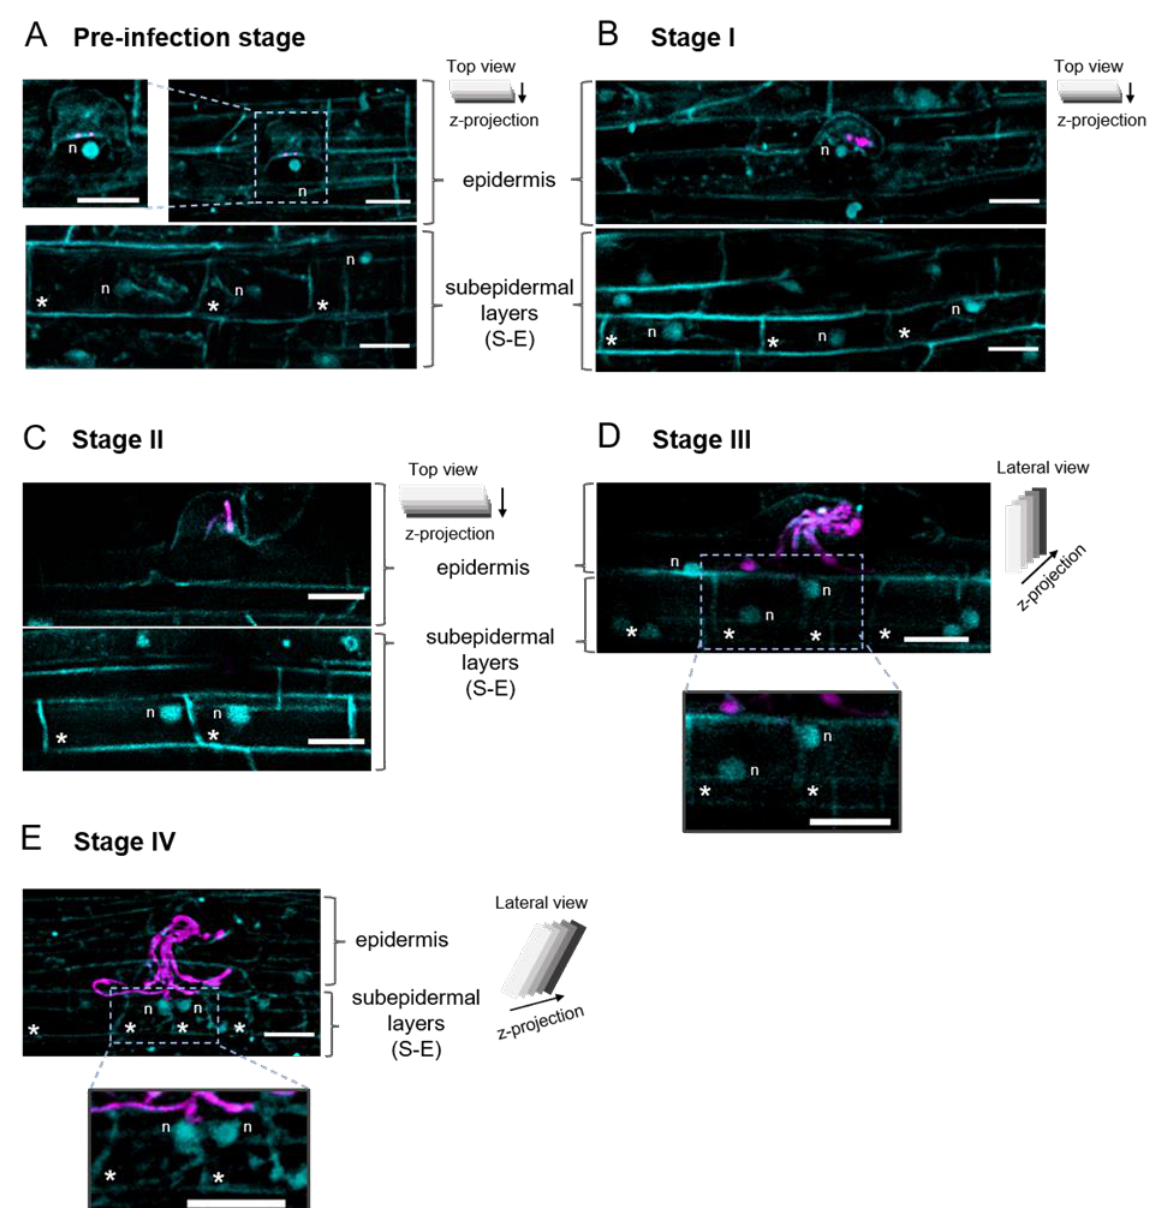
Figure 3. Visualization of the nucleus position in cells at epidermal infection site. The 2D projections of Phaseolus vulgaris roots expressing the nuclear marker NLS-mTurquoise2 or stained with DAPI (blue in both cases) and inoculated with R. etli CE3-DsRed pMP604 (4 dpi). Images are representative of each infection thread (IT) progression stage. Position of the nucleus is variable but correlates with the infection progression. Root hairs at the ( A ) pre-infection stage, as revealed by the detection of rhizobia (magenta) attached to the apical surface of the root hair apical zone. The nucleus was detected at the apical zone, close to the bacterial attachment spot. ( B ) Stage I. The nucleus moves to the nascent infection site. ( D ) Stage III. As the IT progresses, the nucleus relocates to the base of the root hair. In S-E cells, the nucleus is located at different positions in the cells (see Figure 4). ( B ) Stage I. The nuclei are predominantly located at the center of the cell. ( C ) Stage II. The nuclei are observed at the apical zone of the subepidermal (S-E) cells, although at this stage, they tend to be located at the center (see Figure 4). ( D , E ) Stages III and IV, the nuclei are distributed in different locations, with a tendency to be at the apical zone at stage IV. For a better appreciation, insets were added in panels ( A , D , E ), respectively. Nuclei (blue in all panels) in ( A , B , E ) are stained with DAPI; nuclei in